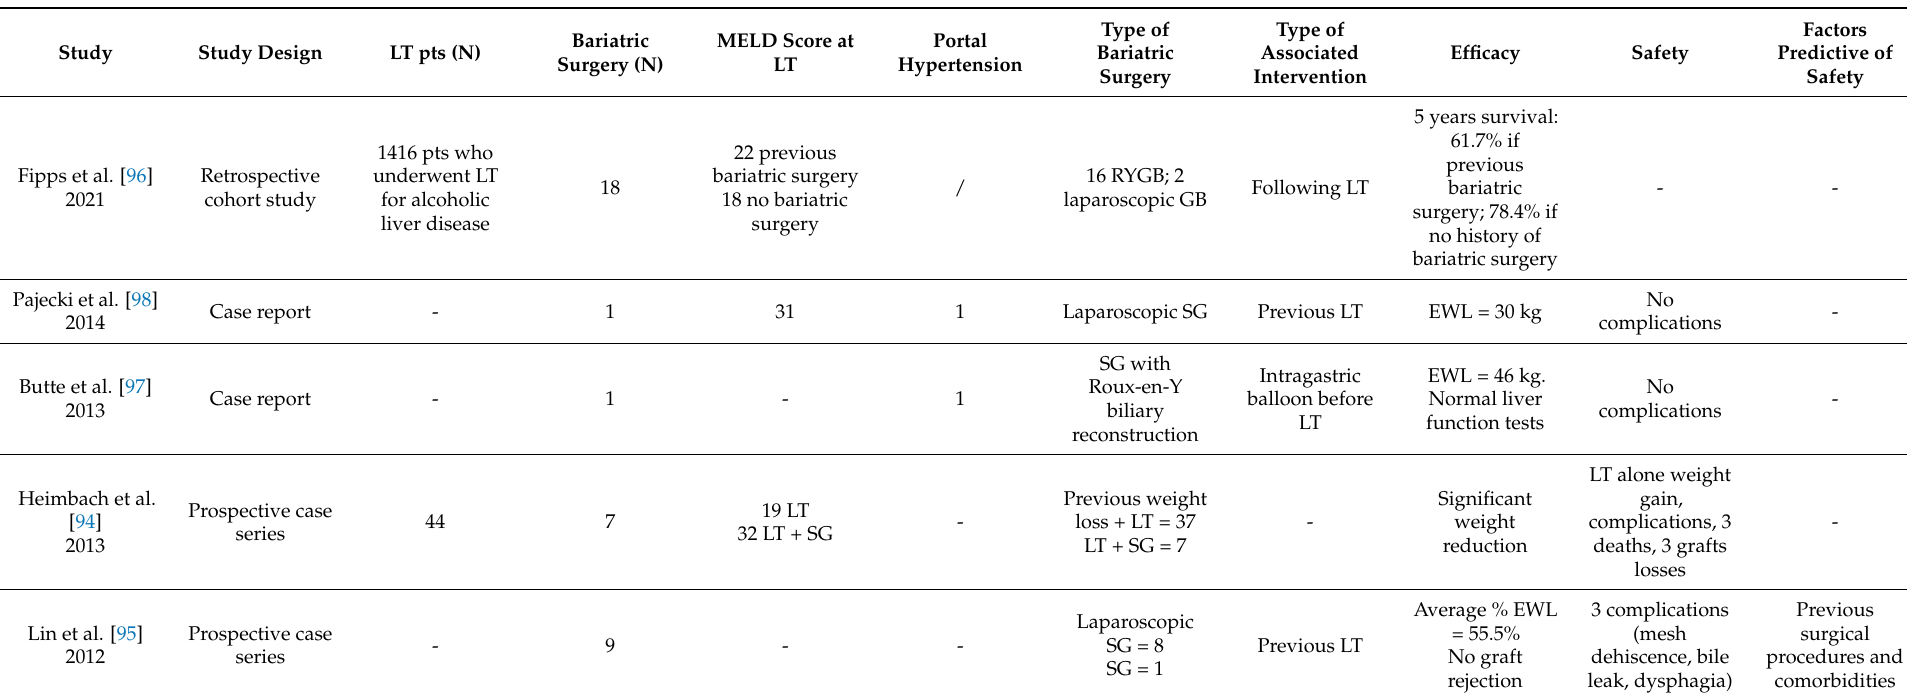
Table 2. Studies including liver transplant (LT) candidates undergoing bariatric